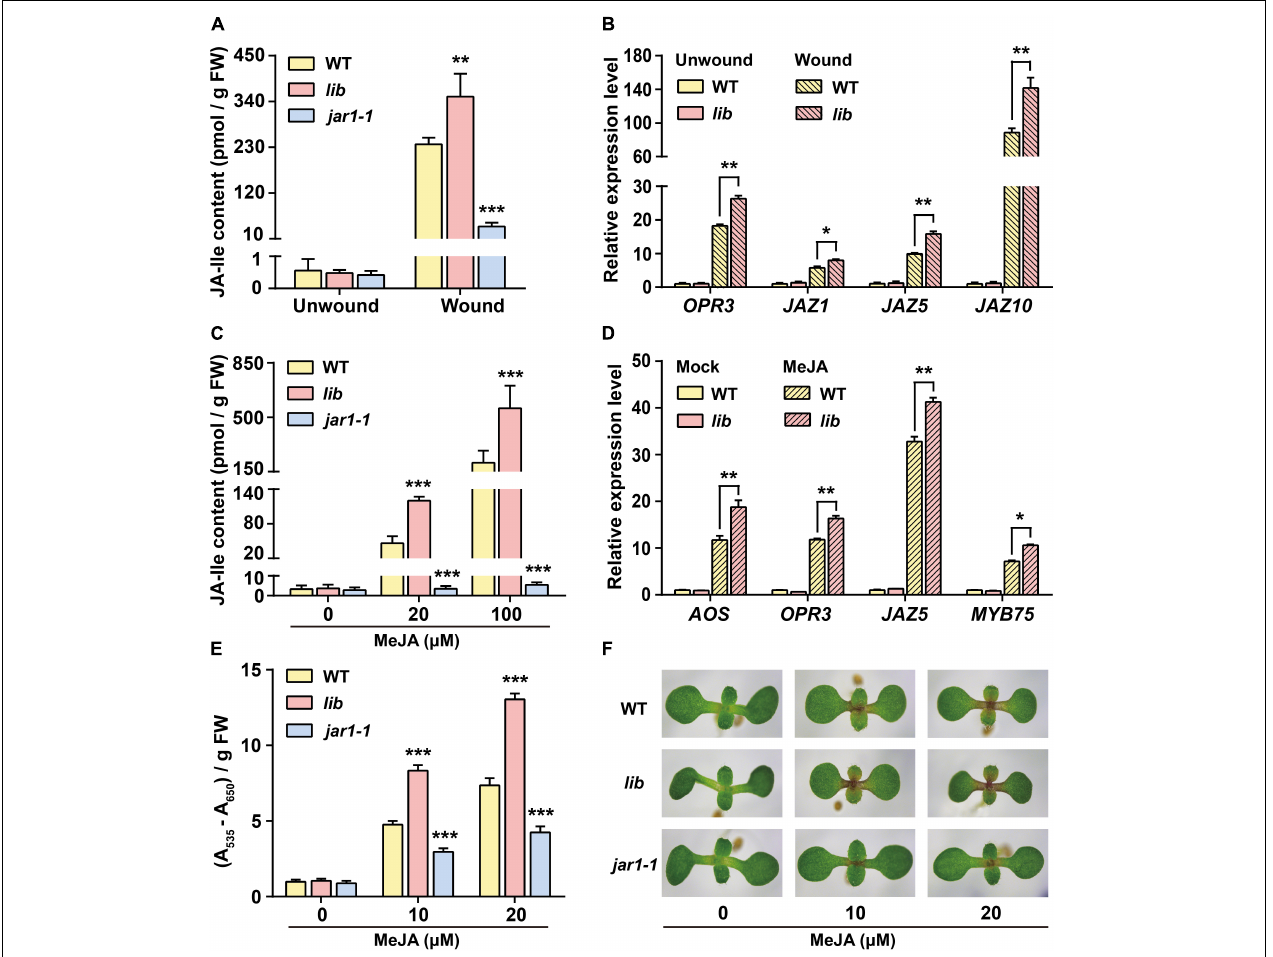
FIGURE 4 | Jasmonate responses are enhanced in lib mutants after wounding and MeJA treatment. (A) JA-Ile content in unwounded and wounded leaves of 4-week-old WT, lib , and jar1-1 seedlings. Data are means ± SD ( n = 5–6 samples). (B) Transcript level of JA biosynthetic gene OPR3 and JA-responsive genes JAZ1, JAZ5 , and JAZ10 in unwounded and wounded leaves of 4-week-old WT and lib plants. ACTIN8 was used as the internal control. Data are means ± SD ( n = 3 samples). (C) JA-Ile content in 14-day-old WT, lib , and jar1-1 seedlings treated with 0, 20, and 100 µ M MeJA for 1 h. Data are means ± SD ( n = 5–6 samples). (D) Transcript level of the JA biosynthetic genes AOS and OPR3 and the JA-responsive genes JAZ5 and MYB75 in 7-day-old WT and lib seedlings treated with solvent (Mock) or 50 µ M MeJA for 1 h. ACTIN8 was used as the internal control. Data are means ± SD ( n = 2–3 samples, each sample contains 20 seedlings). (E,F) Anthocyanin contents (E) and representative phenotype (F) of WT, lib , and jar1-1 seedlings grown on MS medium supplemented with 0, 10, and 20 µ M MeJA for 8 days. Data are means ± SD ( n = 3 samples). Asterisks indicate significant differences compared with WT (Student’s t -test, * p < 0.05; ** p < 0.01; *** p <